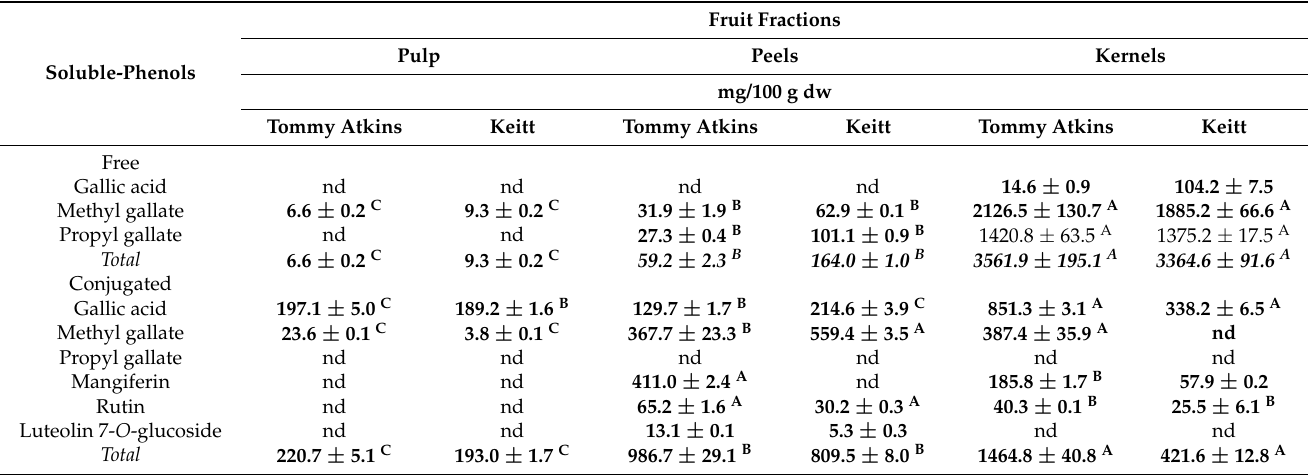
Table 1. Quali-quantitative evaluation of the main soluble-free and soluble-conjugated phenols in the pulp, peels and kernels of ripe mango fruits of the cultivars Tommy Atkins and